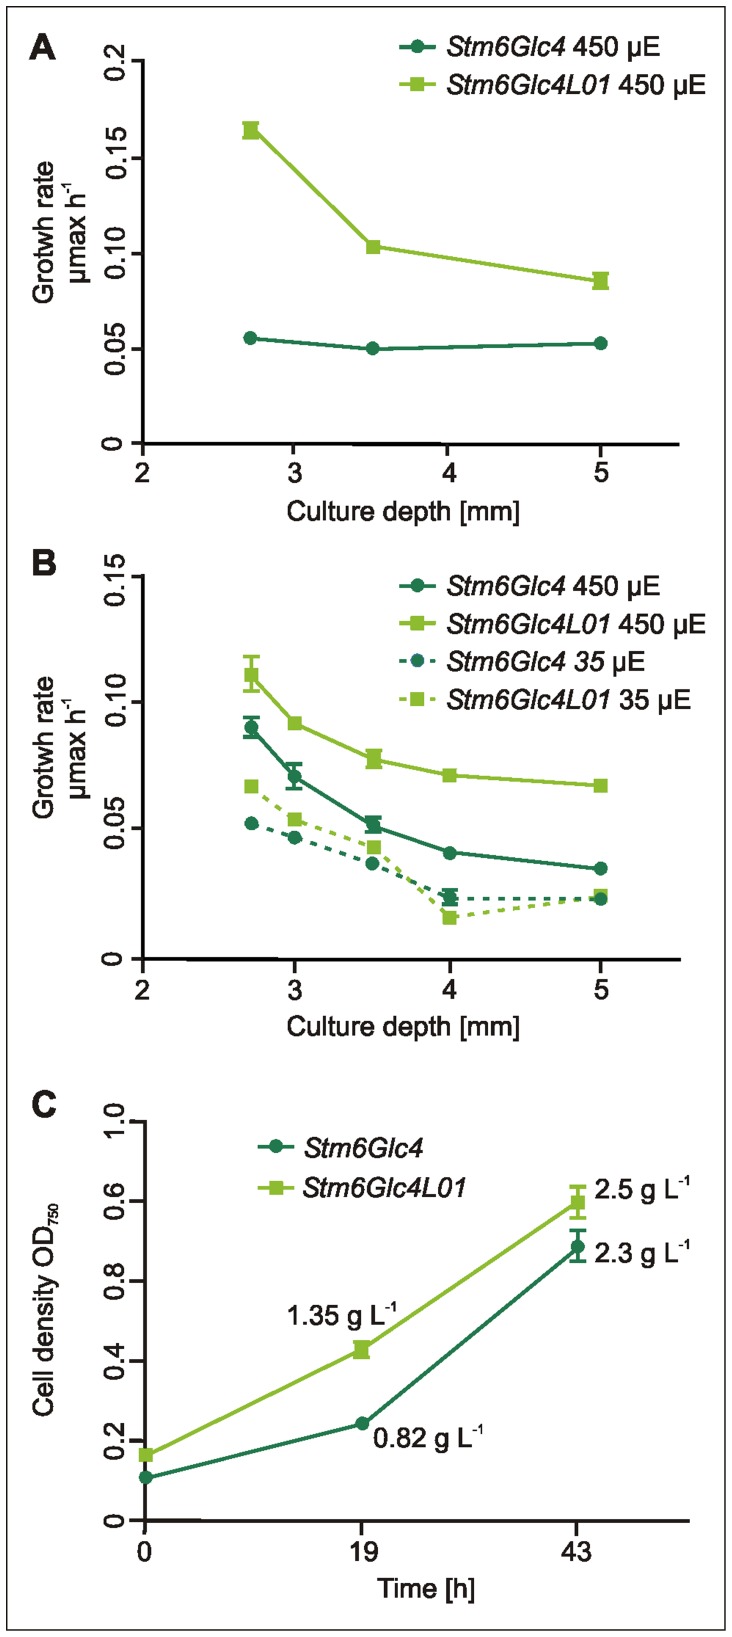
Growth rate µmax h−1 of Stm6Glc4 and Stm6Glc4L01 at different cultivation conditions and biomass determination.(A) Growth rate at 450 µE m−2 s−1 under mixotrophic conditions at different culture depths using start OD750∶0.1. (B) Growth rate at 450 µE m−2 s−1 and 35 µE m−2 s−1under photoautotrophic conditions at different culture depths using start OD750∶0.3. Experimental data were compiled using triplicates. (C) OD750 and biomass determination in g L−1 under photoautotrophic conditions.